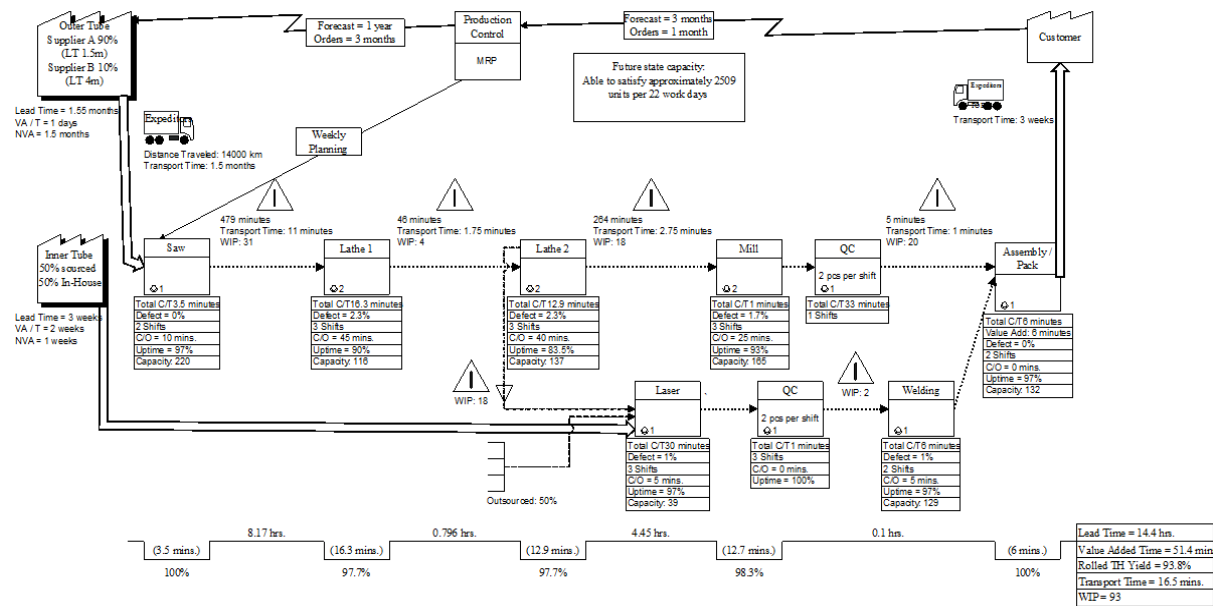
Figure 7. Future state